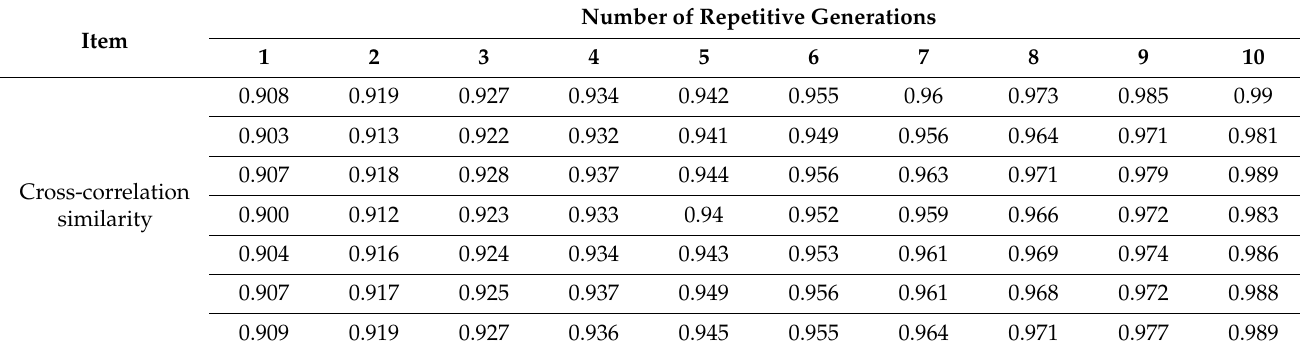
Table 4. Similarity of sEMG signals generated for one motion cycle.